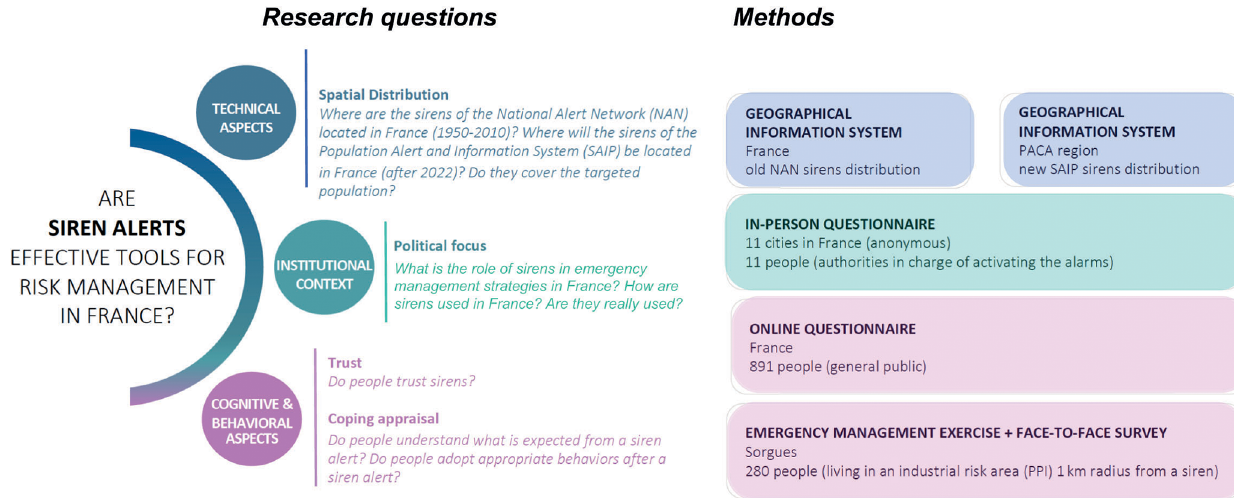
Figure 1. Research questions and